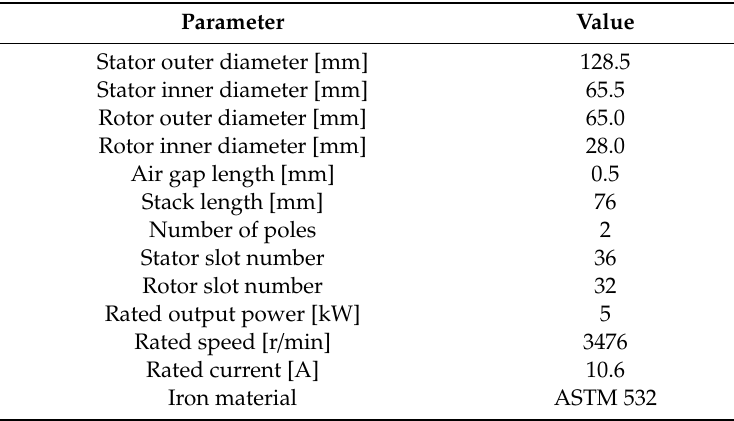
Table 1. Formatted parameters of the